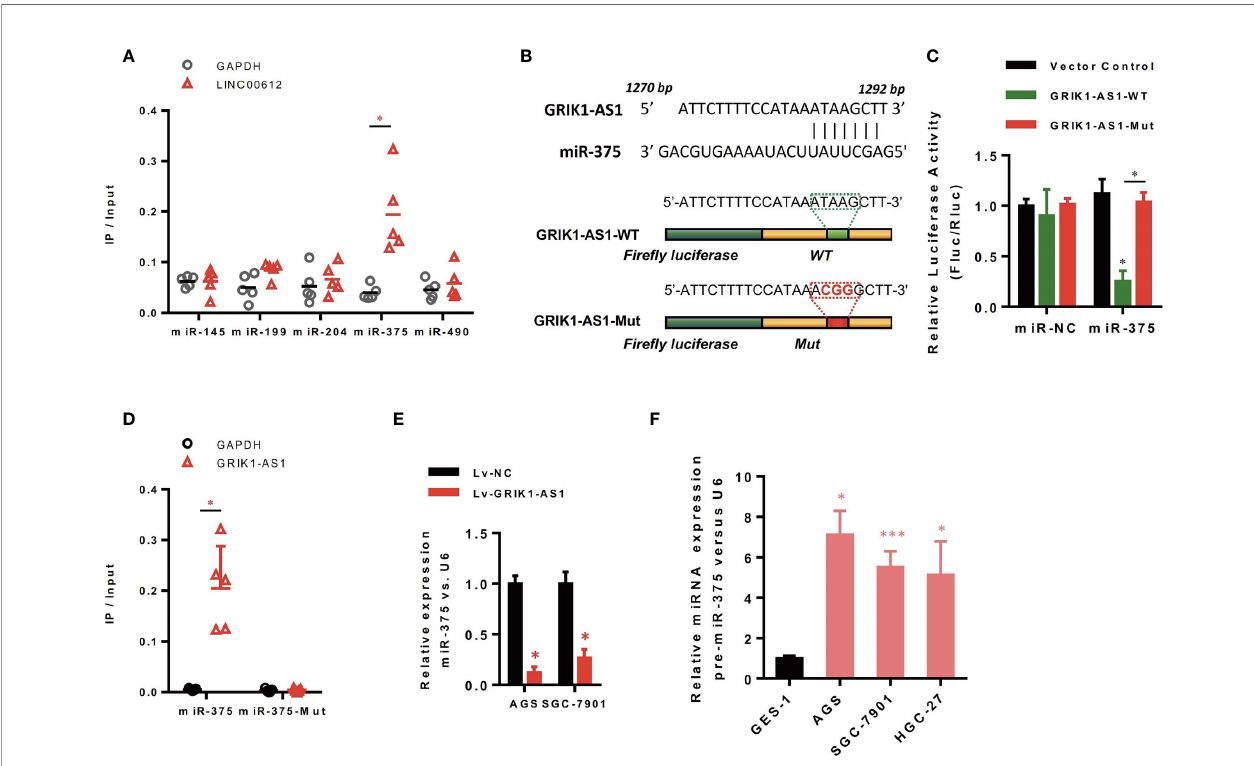
FIGURE 3 | LncRNA GRIK1-AS1 functions as the competitive sponges for miR-375. (A) RNA-pull down was performed to screen out miR-375 and RNA level of GRIK1-AS1 was quanti fi ed by real-time qPCR. (B) A schematic diagram showing the putative miR-375 binding sites with GRIK1-AS1. (C) GRIK1-AS1-WT and GRIK1-AS1-Mut luciferase reporter vectors were co-transfected with miR-375 or miR-NC and then subjected to luciferase activity analyses. (D) RNA-pull down was performed to con fi rm the putative miR-375 binding sites with GRIK1-AS1. (E) Real-time qPCR analysis of miR-375 levels in GRIK1-AS1 over-expressed AGS and SGC-7901 cells. (F) Real-time qPCR analysis of miR-375 level in gastric epithelial cell GES-1 and gastric cancer cells AGS, SGC-7901 and HGC-27. * P < 0.05, *** P < 0.005. Scale bars: